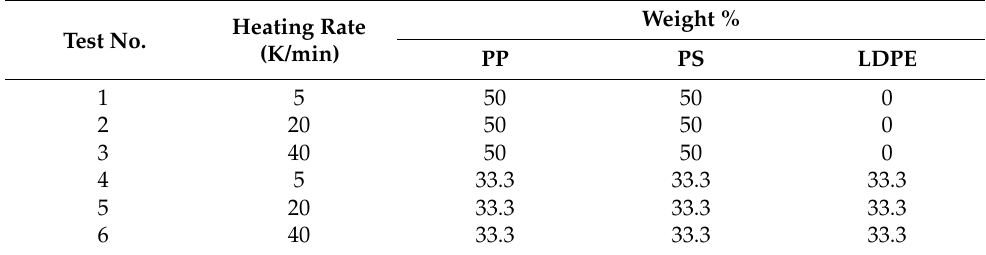
Table 2. Experimental